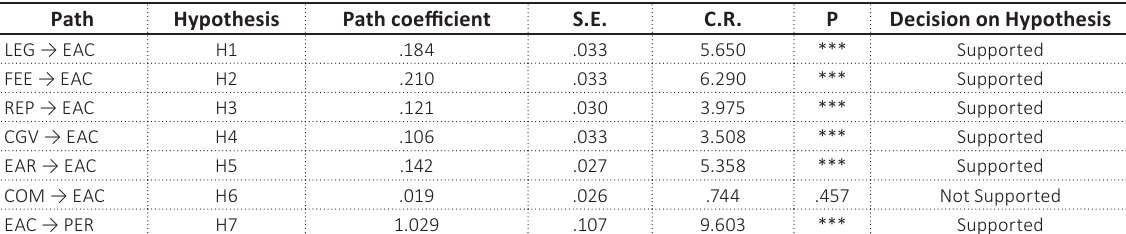
Table 5. Structural equation modeling analysis